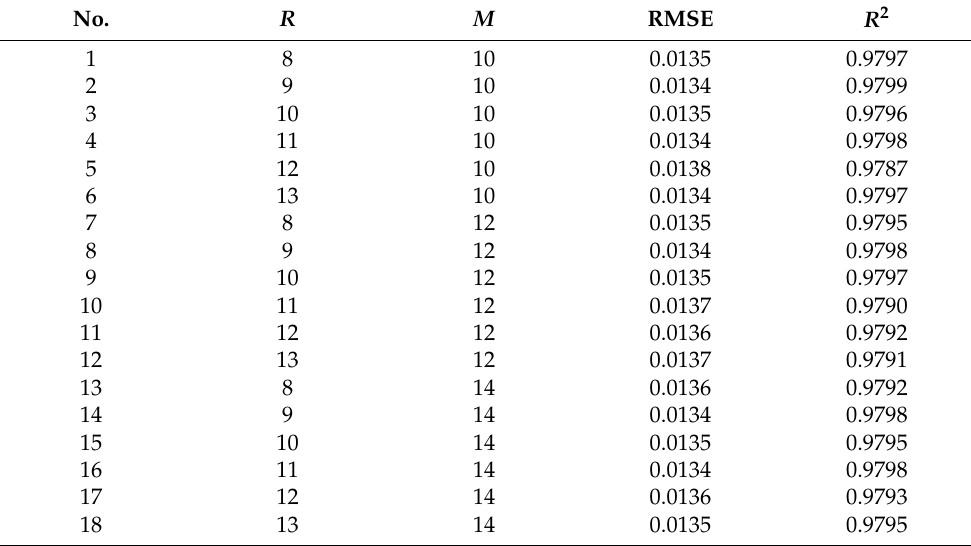
Table 3. Performance comparison of the proposed method under different parameters for prediction of E composition in stream 11.